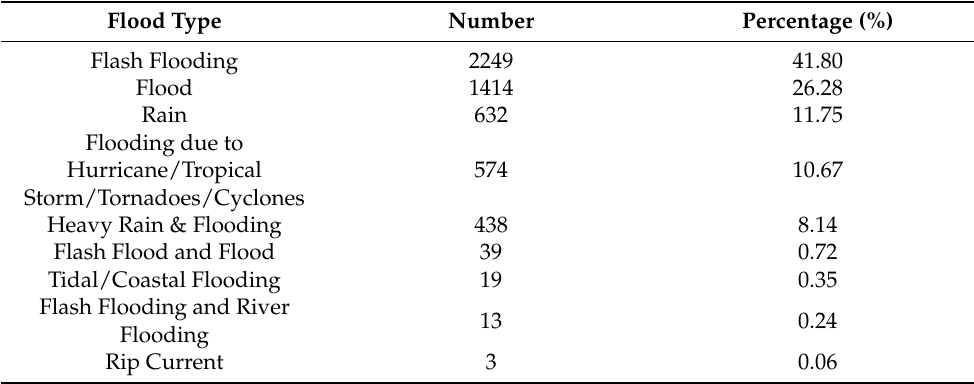
Table 3. Number of food fatalities caused by different flood (event)